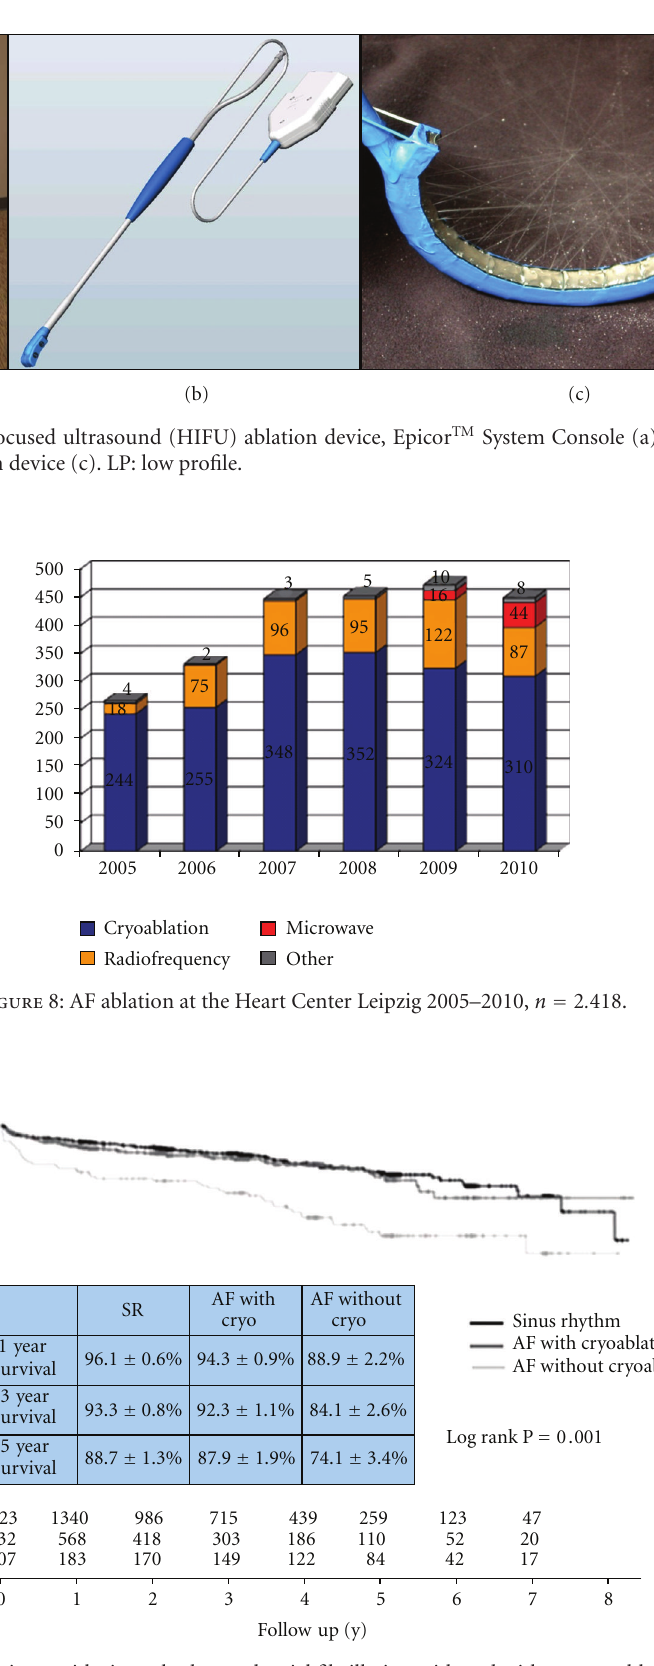
Figure 9: Cumulative survival of patients with sinus rhythm and atrial fibrillation with and without cryoablation after mitral value